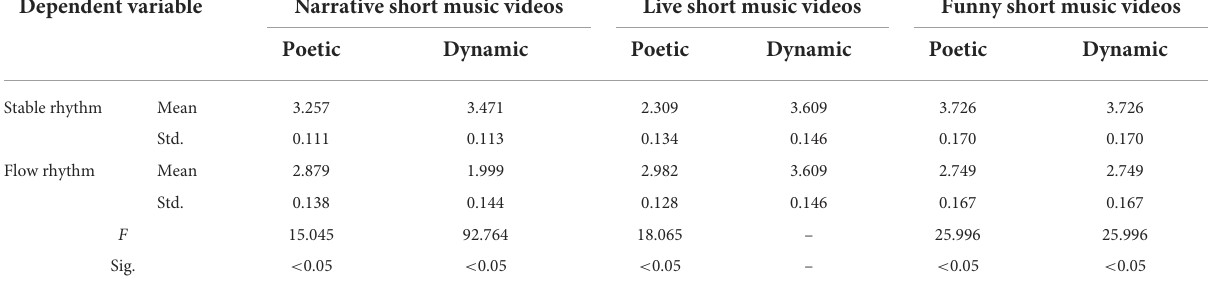
TABLE 7 Simple effect analysis of short music